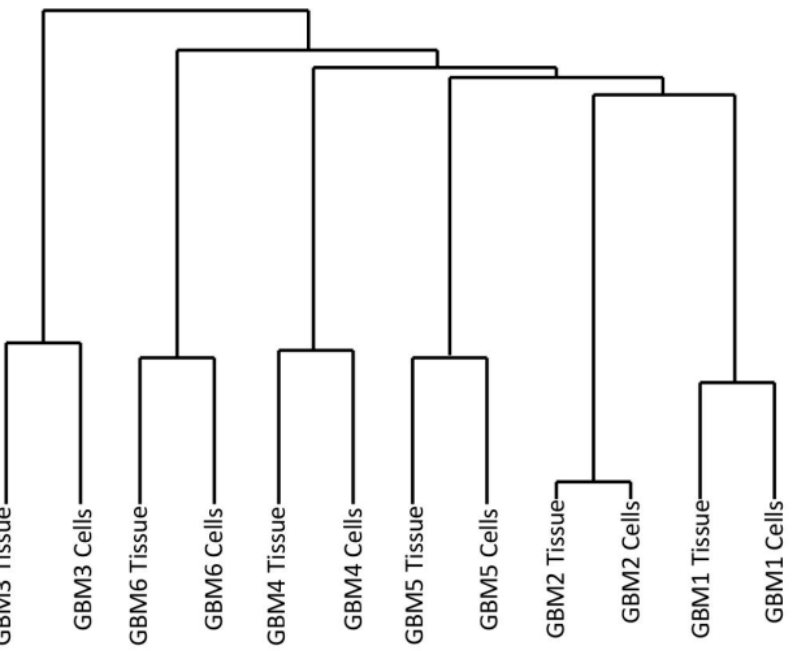
Figure 1. Dimensions 1 and 2 from Multiple Correspondence Analysis (MCA) of genomic variants in Glioblastoma multiforme (GBM) tumour tissue and cell samples ( A ). Dendrogram of GBM samples produced from hierarchical clustering of component values from dimensions 1-10 of the MCA ( B ).